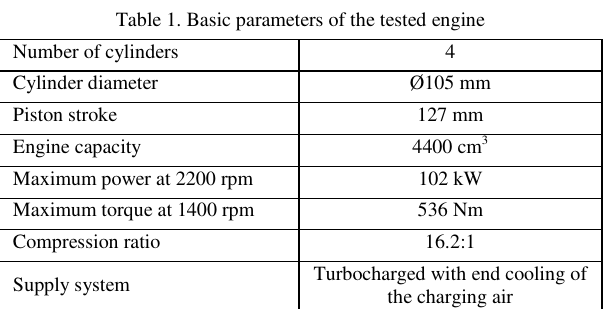
Table 1. Basic parameters of the tested engine